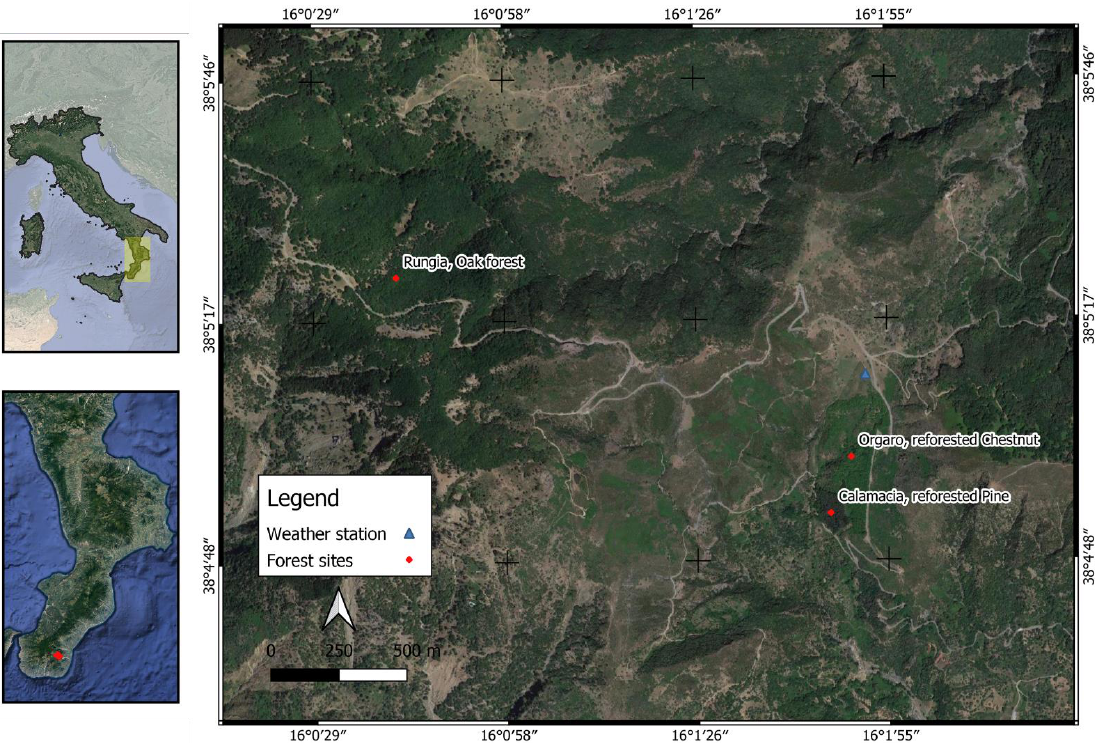
Figure 1. Location of the experimental forest sites (Samo, Calabria, Southern Italy); datum: EPSG: 4326 WGS 84. All soils have a loamy sand texture, except the unburned area of the pine forest, which is sandy loam (Table 2).